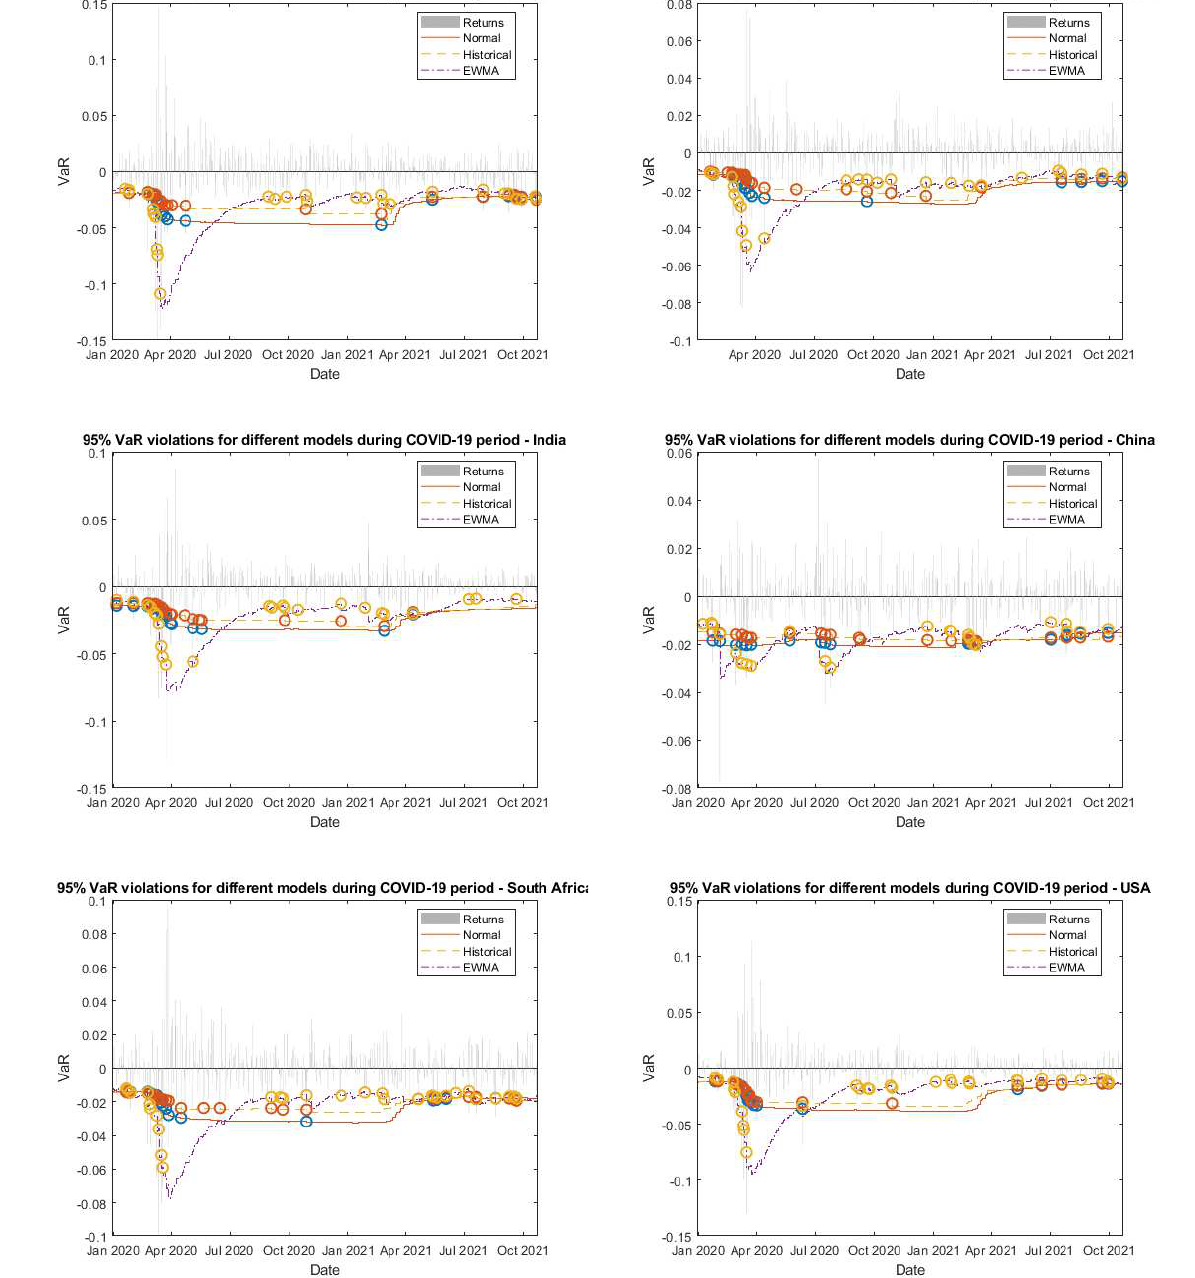
Brazil, Russia, India, China, South Africa, and the USA. Figure 3. Comparison of returns and VaR at 95% for different models (COVID-19,